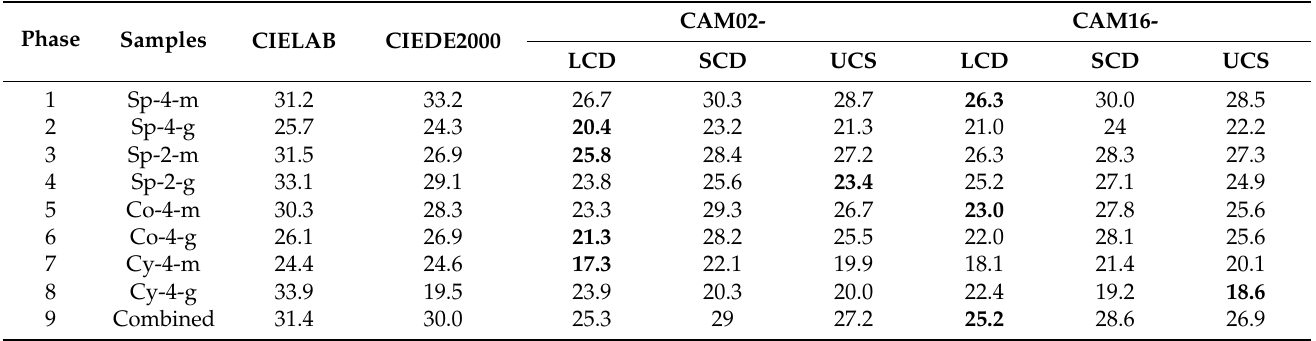
Table 6. STRESS values [25] achieved by eight color-difference formulas based on values of the lightness parametric factor k L shown in Table 5. Numbers in bold indicate the best color-difference formula for each phase.